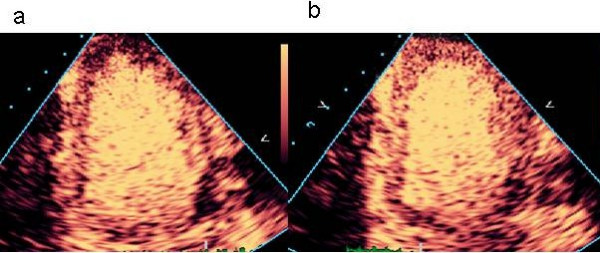
False positive defects with real-time MCE. Pseudo-apical defects are due to apical bubble destruction (a). Relocation of the focus from the base toward the apex (b) leads to "resolution" of the apical abnormality, but use of a mid-ventricular focus placement may lead to more problems with definition of the basal segments. This case also exemplifies attenuation of the basal lateral segment by contrast within the LV cavity.